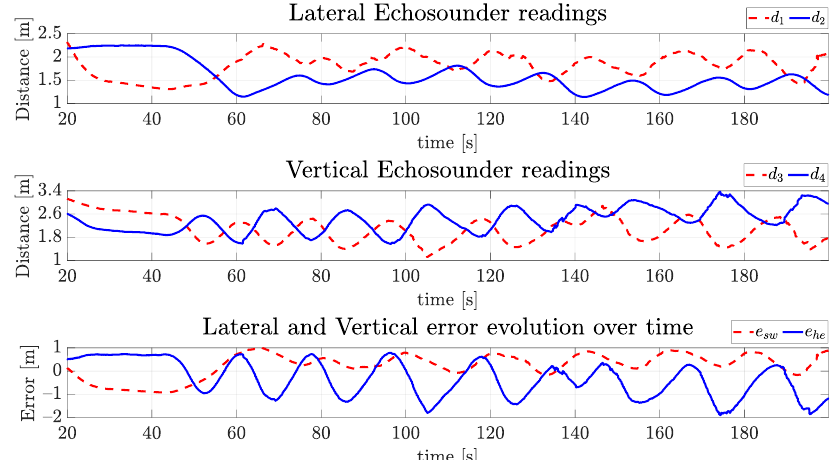
Figure 25. Readings of echosounders of VITA1 and the vertical and horizontal errors over time for the real